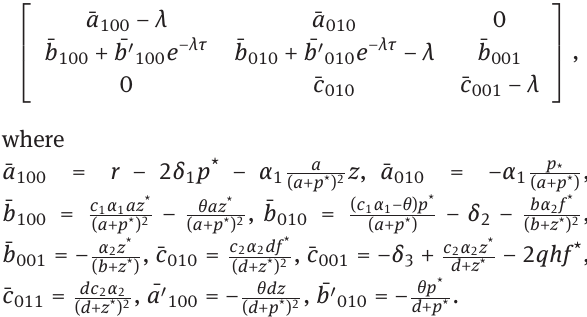
μ onto τ -space is bounded which includes an in- ( R * , τ k , 2 Π ) σ 0 ). We note that τ terval of the form (0, τ k and by Lemma 5.1, we have 0 < T < τ longing to μ . This implies that the projection of ( R * , τ k , 2 Π ) σ 0 μ onto T -space is bounded. We also know that ( R * , τ k , 2 Π ) σ 0 onto τ -space is bounded if the pro- projection of μ ( R * , τ k , 2 Π ) σ 0 jection of onto is bounded. Thus, the connected compo- , 2 Π ) is bounded, leading to a contra- nent through ( R * , τ k σ 0